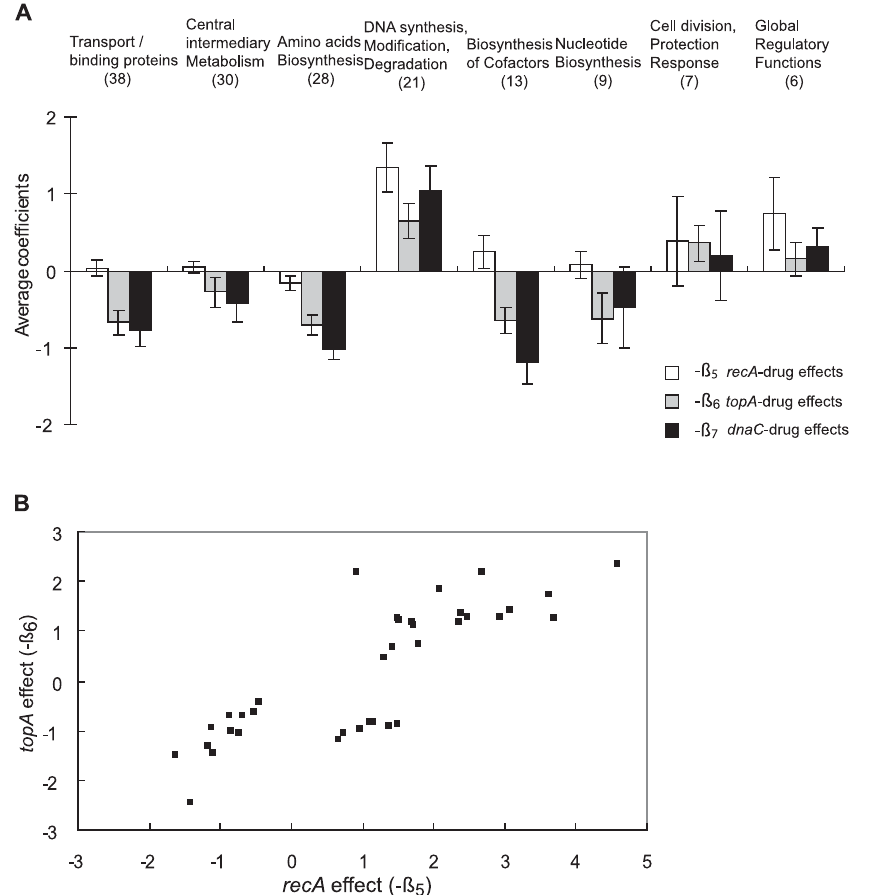
Figure 3. Average Coefficients of Gene–Drug Interactions The b 5 , b 6 , and b 7 values in different functional groups (A) and association between the recA and topA mutation effects (B) are shown. (A) For the sake of convenience, the average coefficients are shown with opposite signs ( (cid:1) b 5 , (cid:1) b 6 , and (cid:1) b 7 ), so that the positive values indicate the increase in transcript levels and the negative indicates the decrease. The number of genes in each functional group is in parenthesis, and the error bars represent two standard errors. (B) The interactions between the recA– drug ( (cid:1) b 5 ) and topA– drug ( (cid:1) b 6 ) effects can be seen as the positive correlations for 36 selected genes (r ¼ 0.82; p , 0.1 in both (cid:1) b 5 and (cid:1) b 6 ).